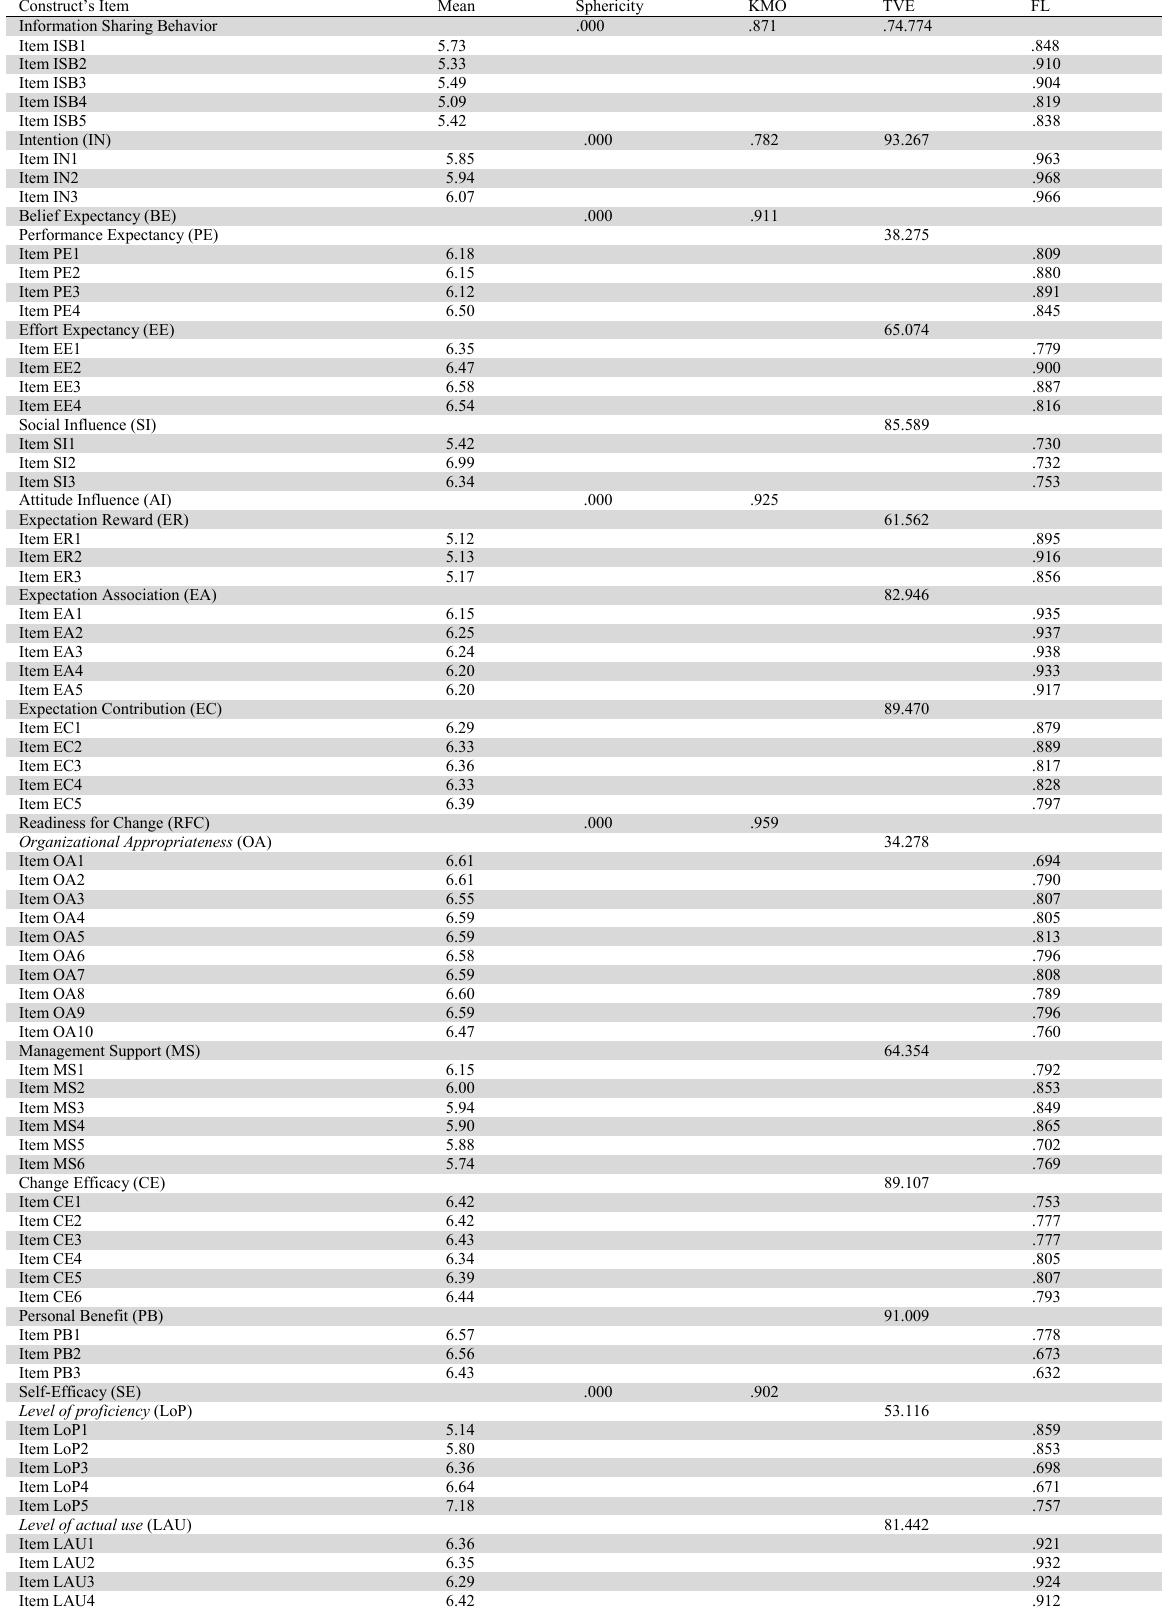
Descriptive Statistic (Mean and Standard Deviation) Construct’s